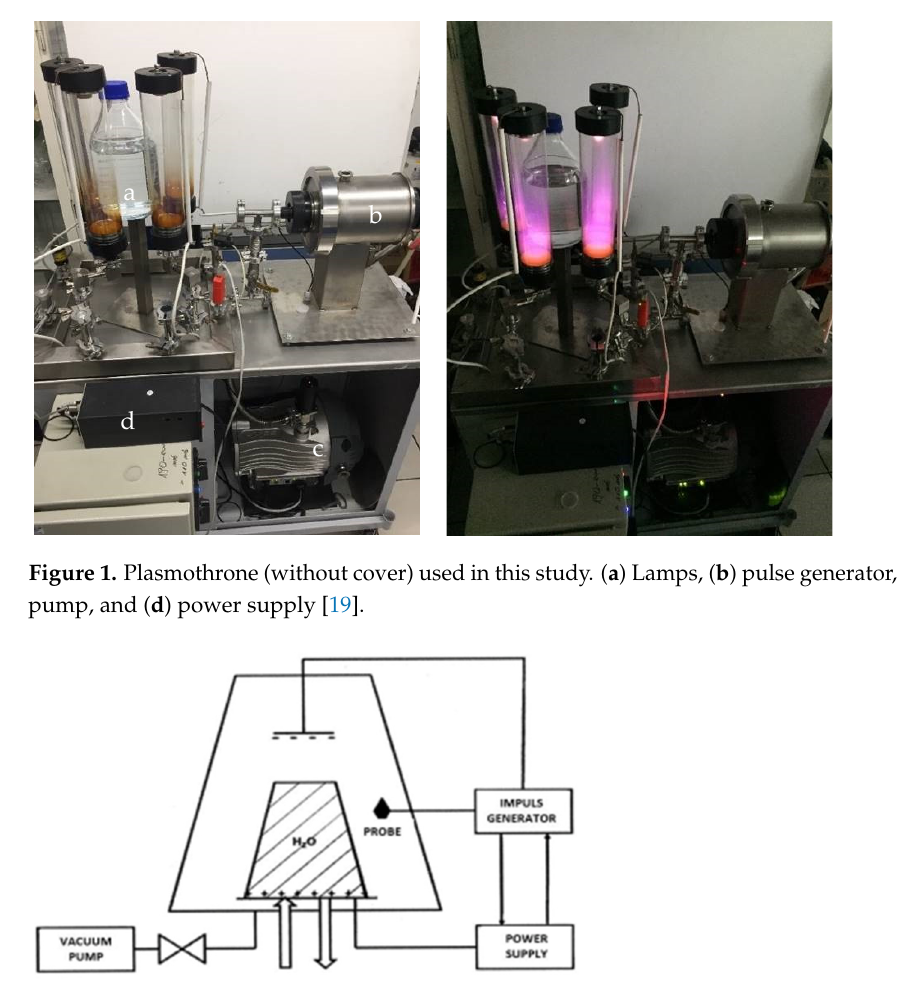
Figure 2. Scheme of the glow plasma (GP) generator and the mode of treating water with it [18]. Plasma-treated water (PTW) is water that has been exposed to low-temperature, low- pressure, low-frequency glow plasma. This water is obtained under laboratory conditions by placing a glass bottle (e.g., a Pyrex bottle) with a capacity of up to 2000 mL into